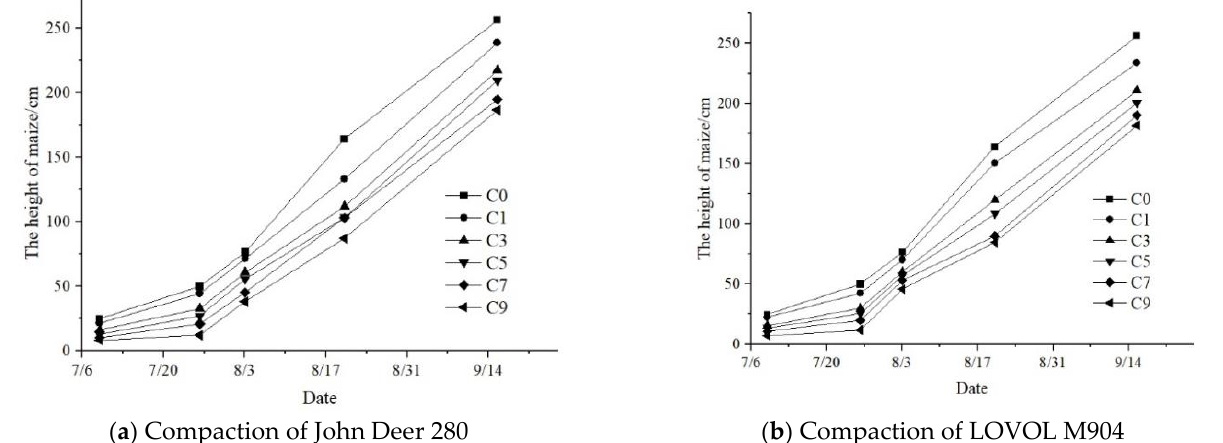
Figure 5 . Effect of soil compaction on the height of